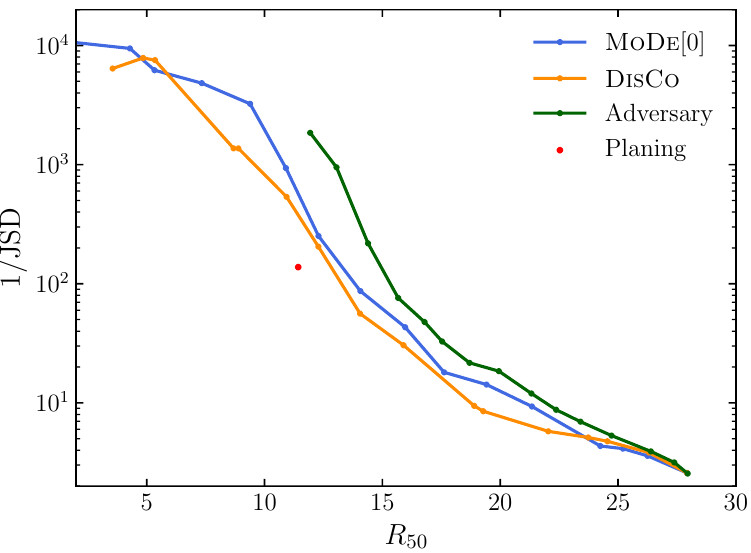
Figure 7 . Decorrelation versus background-rejection power showing that MoDe [0] performs sim- ilarly to existing state-of-the-art decorrelation